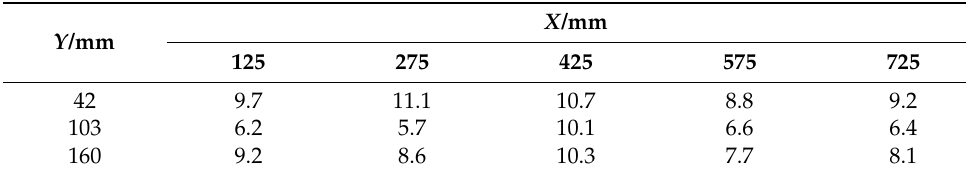
Table 2. Airflow velocity of measuring points (m · s − 1 ).